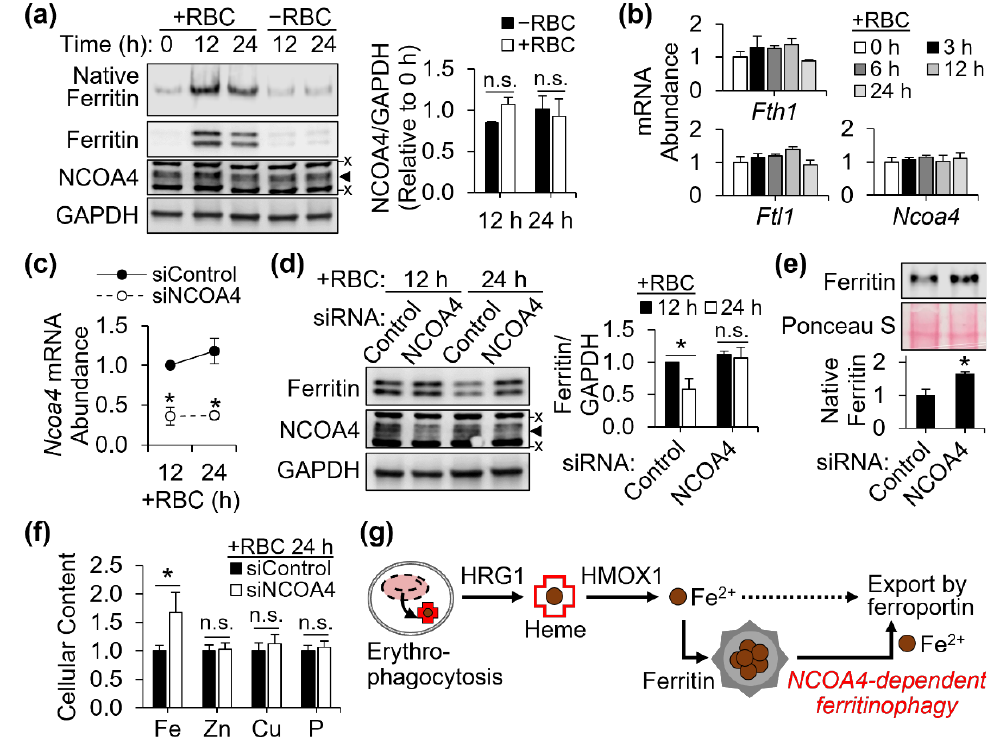
Figure 4. NCOA4 facilitates ferritin turnover and cellular iron release at later stage of erythrophago- cytosis. J774 cells were treated with opsonized red blood cells at 0 h and washed at 2 h to remove non-ingested red cells. For NCOA4 depletion, cells were transfected with NCOA4 siRNA 24 h prior red cell treatment. ( a ) Expression of NCOA4 and native ferritin in erythrocyte-treated cells ( n = 3 independent experiments). ( b ) Lack of changes in ferritin ( Fth1 , Ftl1 ) and Ncoa4 transcript abun- dance by erythrophagocytosis, normalized to Tbp ( n = 3 biological replicates). ( c ) NCOA4 knock- down confirmed by qPCR ( n = 3 independent experiments) ( d ) Steady ferritin expression after erythrophagocytosis in J774 cells deficient of NCOA4. Protein abundance was normalized to GAPDH ( n = 4 independent experiments). ( e ) Higher abundance of ferritin oligomers after 24 h of erythrophagocytosis in NCOA4-deficient cells, detected by western blot analysis of equal amounts of protein separated by native PAGE ( n = 3 biological replicates). ( f ) Cellular mineral contents of erythrocyte-ingested J774 macrophages with or without NCOA4 deficiency, normalized to cell counts ( n = 5 biological replicates). ( g ) Schematic illustration of the flux of iron and regulated ferri- tinophagy at different iron-recycling steps after erythrophagocytosis. All data presented as mean ±